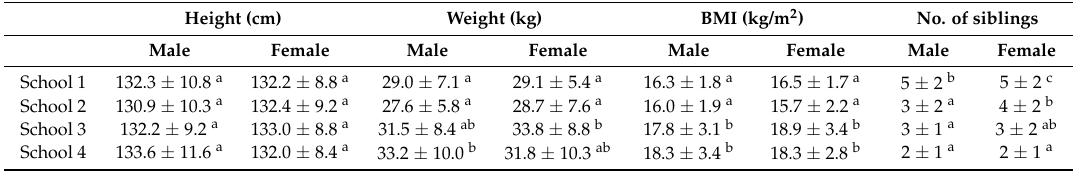
Table 1. Relevant characteristics of the children in the four schools studied.